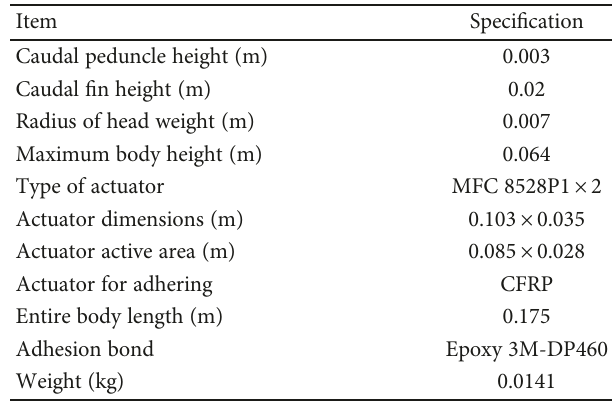
Table 4: Speci fi cations of the new soft robotic fi